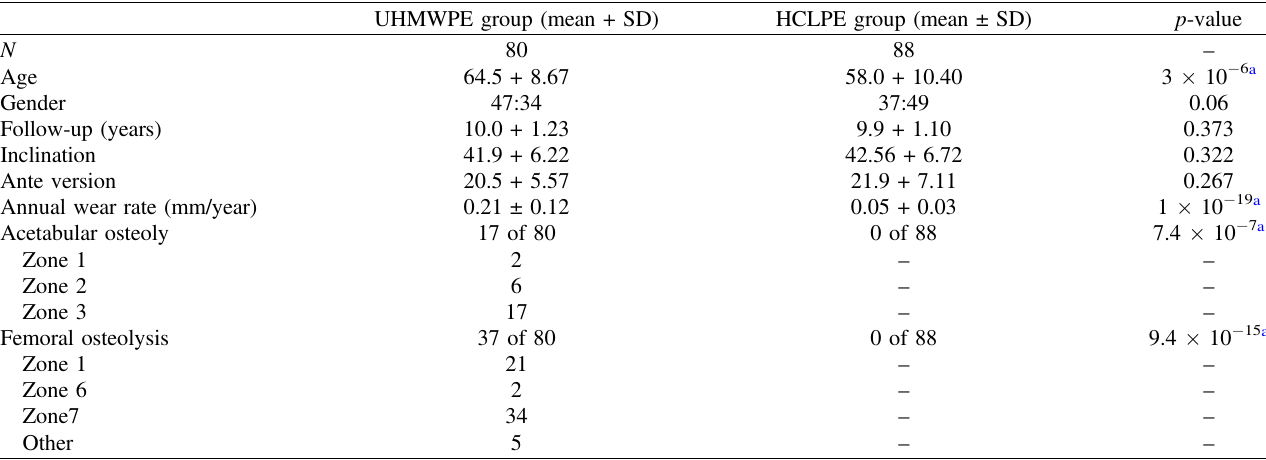
Table 1. Patient demographics and radiographic measurements for UHMWPE and XLPE study